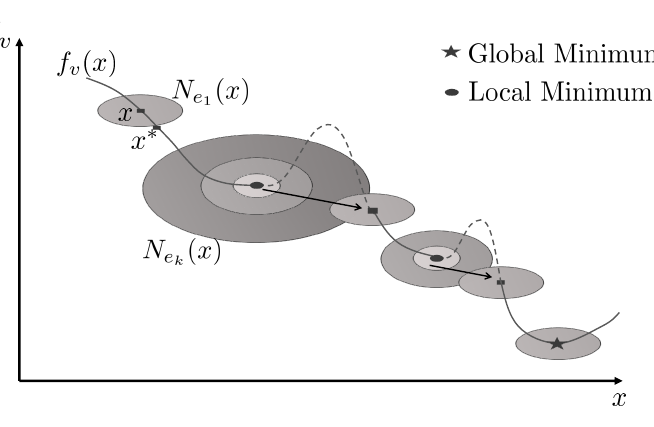
Figure 3. The VNS algorithm. Adapted from